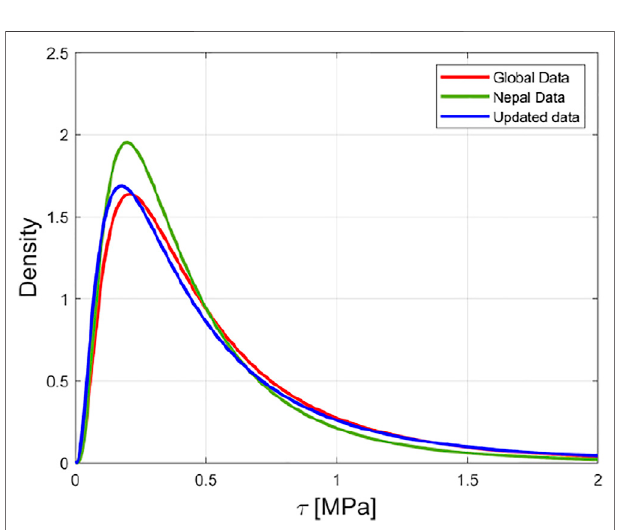
FIGURE 7 | Comparison of Nepalese shear data to global shear data and updated data relative contribution of RC frame.